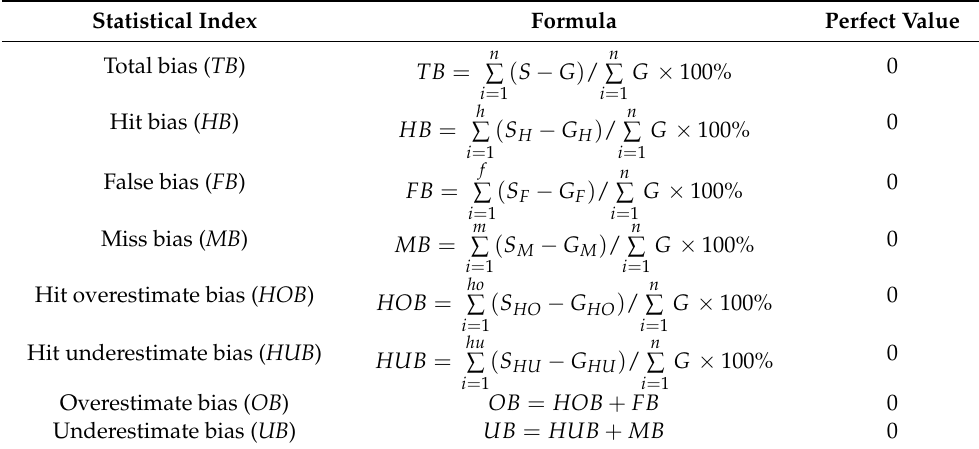
Table 3. The statistical metrics used to quantify the performance of IMERG.